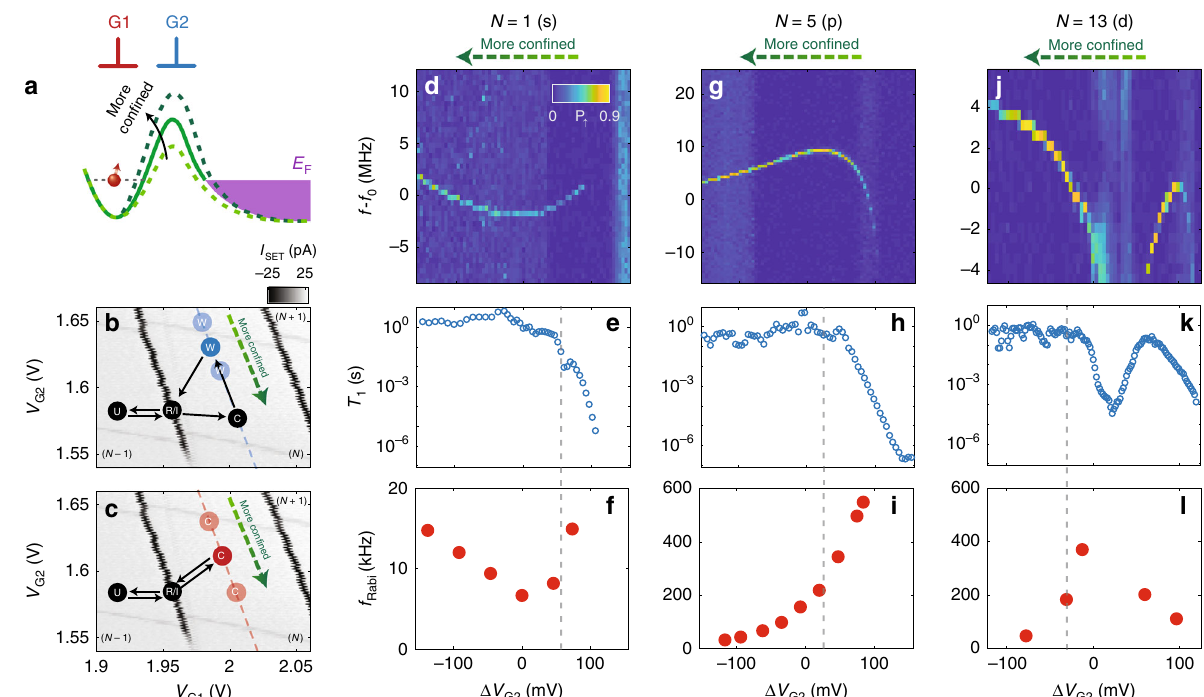
Fig. 3 Stark shift, tunable Rabi frequency and relaxation time. a Schematic representation of the quantum device energy band diagram. G2 voltage varies in order to change the quantum dot size and tunnel rate to the reservoir (purple). Compensating voltage is also applied to G1 to maintain the quantum dot energy level relative to the Fermi level E F . b , c Schematics of the pulse sequences for ( b ) T 1 relaxation, and ( c ) Rabi control experiment. The qubit control point varies along the dashed line inside the charge stability diagram, parallel to the charge transitions, with electron occupancy either N = 1, 5 or 13. d Non- linear Stark shift of qubit resonance frequency is observed when the qubit control point changes along dashed line in ( b ) and ( c ), for N = 1 electron. At certain voltage levels, the resonance frequency shifts dramatically and eventually qubit read-out is unachievable. e Correlation is observed between the magnitude of the differential ESR resonance frequency ( f − f 0 ) and qubit relaxation time T 1 . f Correlation is also observed between f − f 0 and Rabi frequency f Rabi . There is a qualitative correlation between the maximum Rabi frequency and the non-linearity of the Stark shift. g – l Stark shift, T 1 and Rabi frequencies as plotted in Figs. ( d – f ), but for ( g – i ) N = 5 and ( j – l ) 13 electrons. Examples of advantageous qubit operation voltages, where a balance exists between fast Rabi oscillation and long spin lifetime, are drawn as grey vertical lines in the fi gure. f 0 = 41.835, 41.870, 41.826 GHz for N = 1, 5 and 13 electrons,